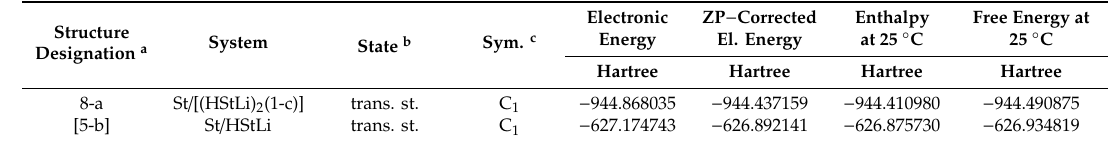
Table A2. Calculated electronic energies, zero-point(ZP)-corrected electronic energies, enthalpies ( H ) and Gibbs free energies ( G ) at 25 ◦ C in cyclohexane for the transition states of the reaction of dimeric (HstLi) 2 and non-associated HStLi with